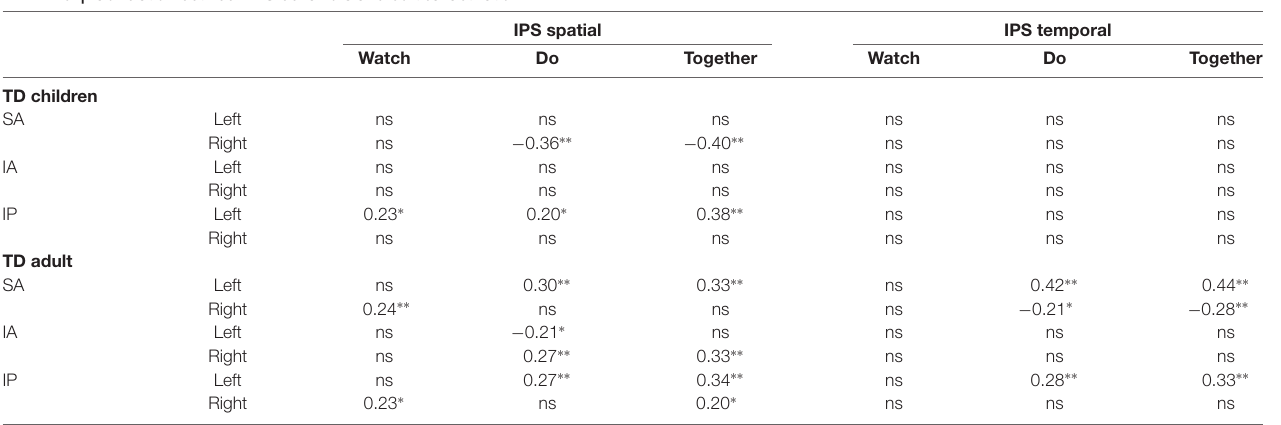
TABLE 5 | Correlation between IPS behaviors and cortical activation.